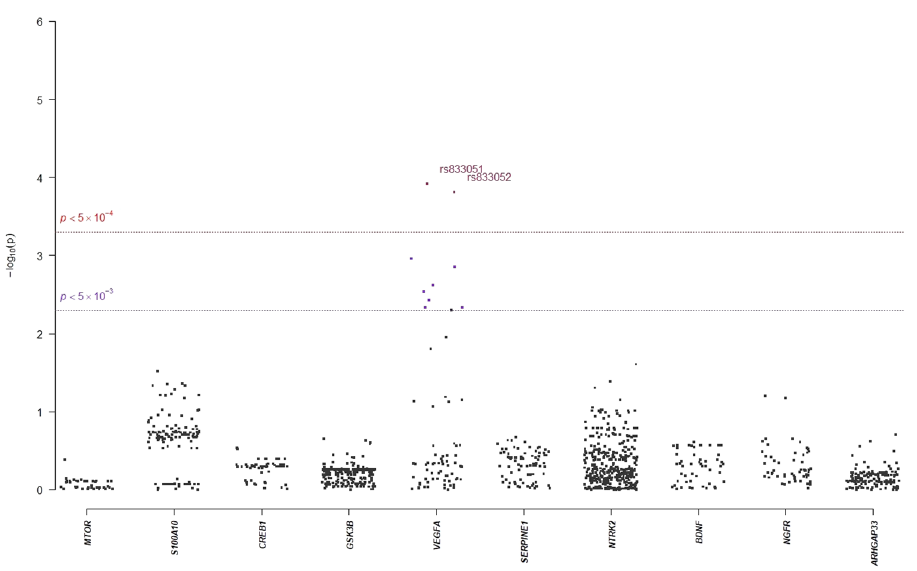
Figure 4. Manhattan plot of mega-analysis of selected candidate genes for Response (% Δ HRSD,